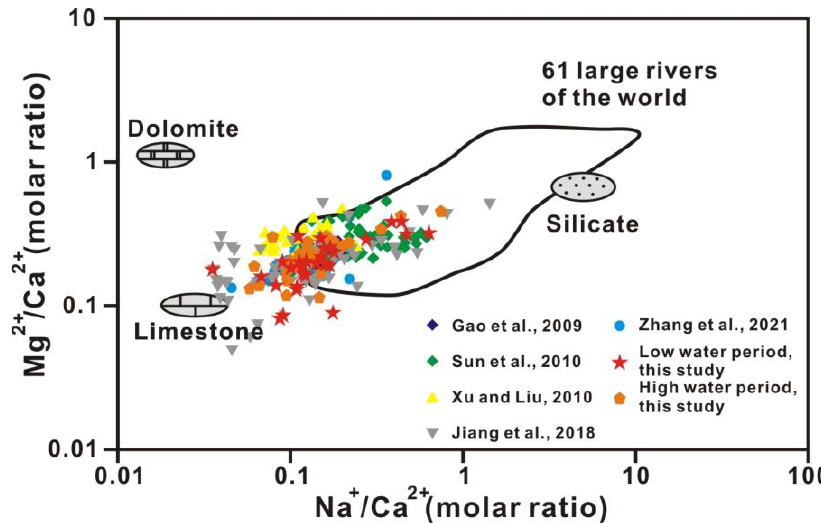
Table 3. Molar ratios of the river end-members [44].